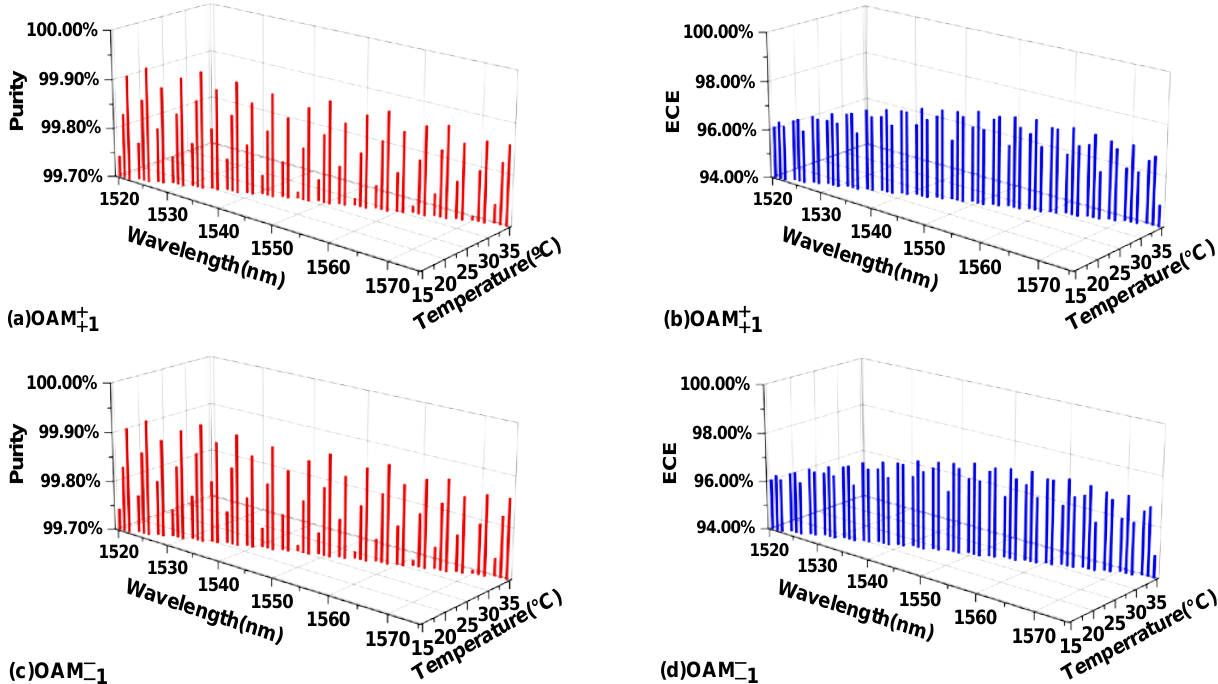
Figure 10. ( a , b ) The purity and energy conversion efficiency (ECE) of the +1st order OAM mode in the wavelength range of 1520–1575 nm when CPFM is input. ( c , d ) The purity and energy conversion efficiency (ECE) of the − 1st order OAM mode in the wavelength range of 1520–1575 nm when CPFM is input.